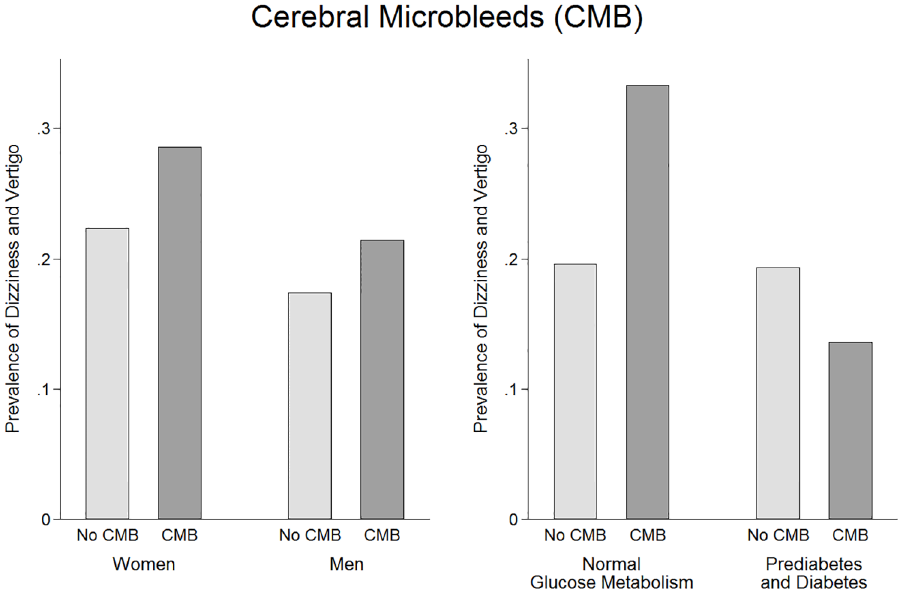
Fig 2. Prevalence of 12-month dizziness and vertigo according to groups with and without cerebral microbleeds. In women and men (Panel A) and in persons with normal glucosemetabolismand in prediabeticor diabetic persons(Panel